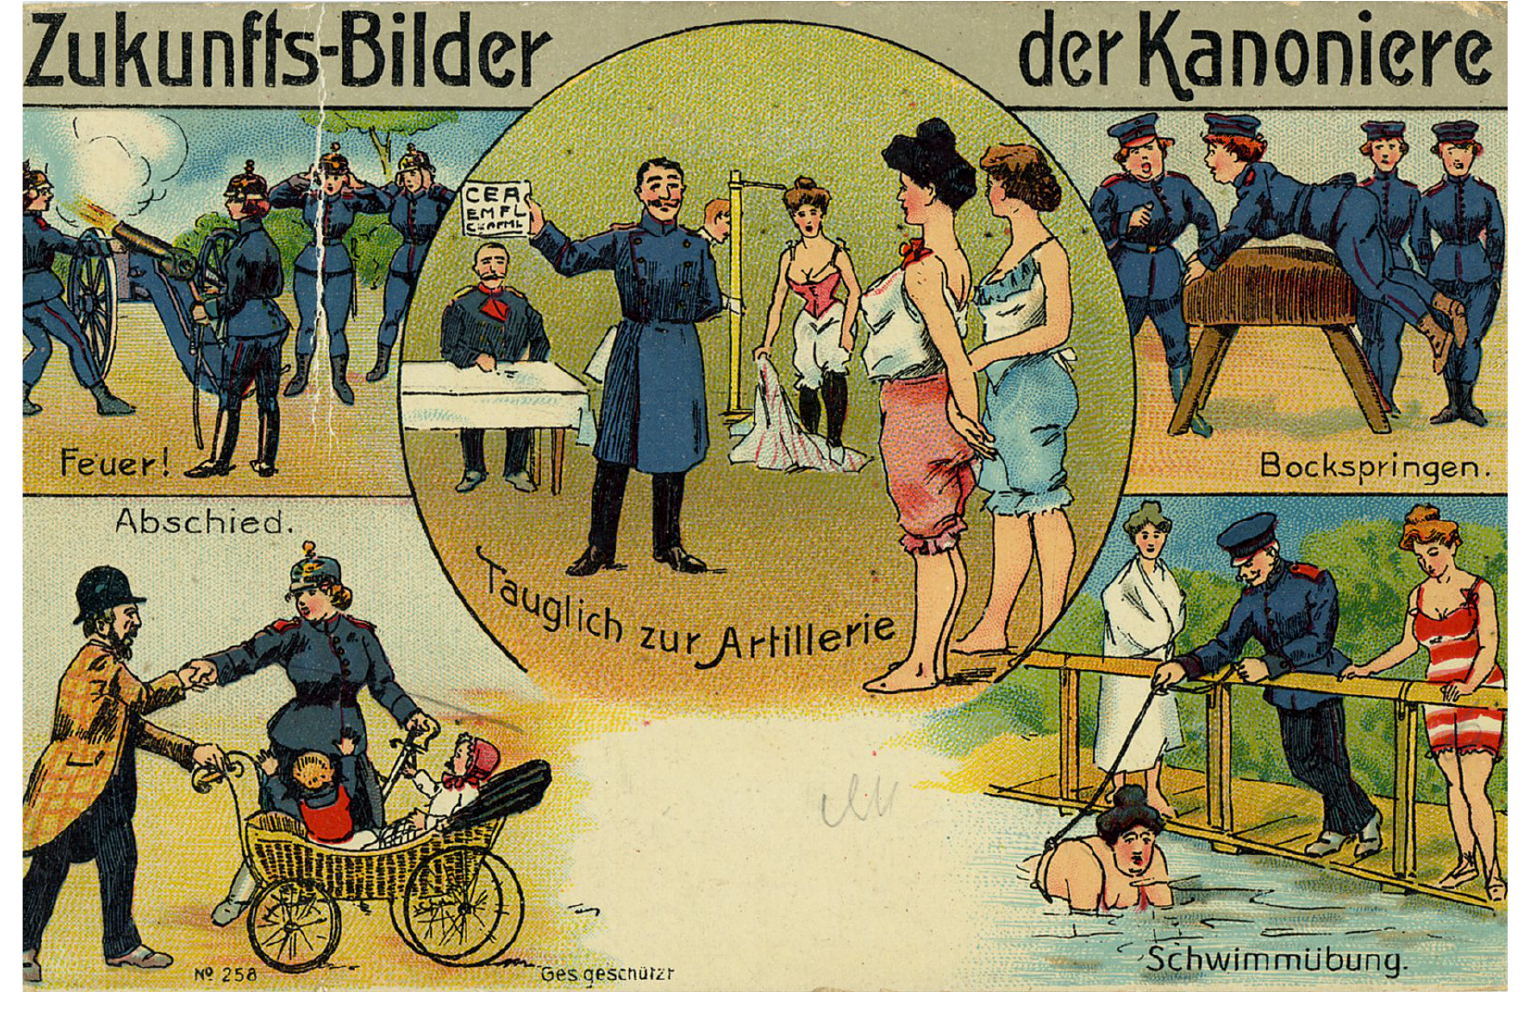
Artist unknown, Zukunfts-Bilder der Kanoniere (Pictures from the Future of the Cannoneers). c. 1907. Postcard. Stiftung Historische Museen Hamburg-Altonaer Museum. 13.8 x 9